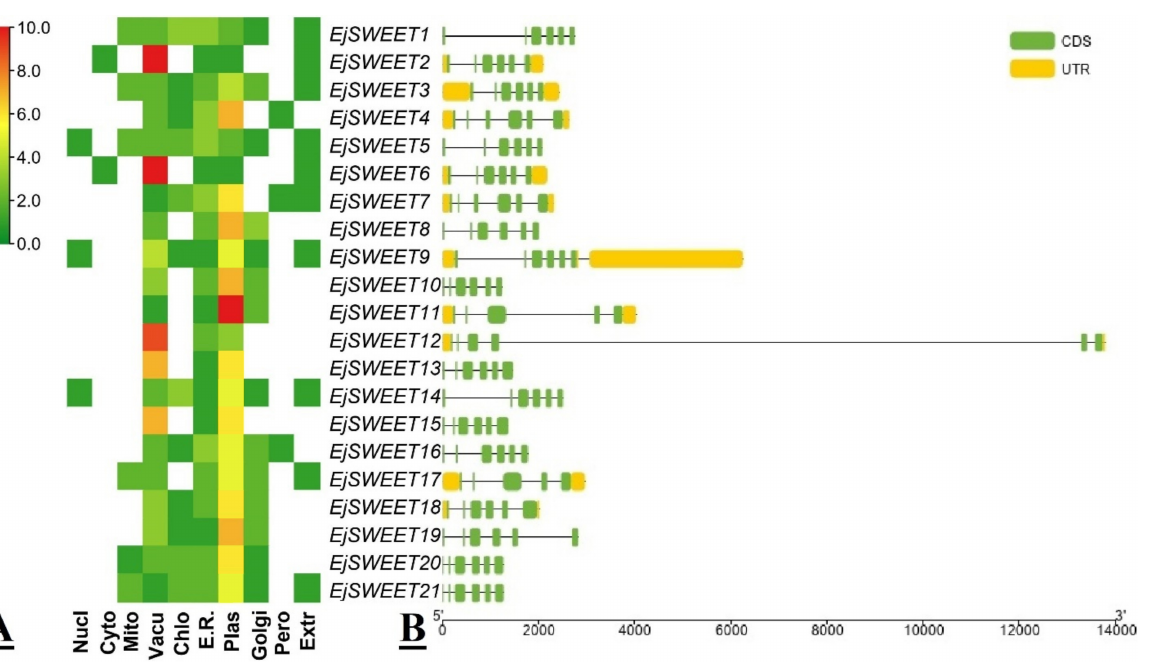
Figure 1. ( A ) Protein subcellular localization prediction of loquat SWEETs. Maximum and minimum signals are shown with red and green color boxes, respectively, while white color boxes represent no available data. Abbreviations: Nucl, nucleus; Cyto, cytoplasm; Mito, mitochondria; Vacu, vacuole; Plas, plasma membrane; Chlo, chloroplast; Golgi, Golgi apparatus; E.R., endoplasmic reticulum; Pero, peroxisomes; Extr, extracellular region. ( B ) Gene organization of EjSWEETs . The green boxes represent exons and the black lines represent introns, while untranslated regions (UTR) are denoted by yellow